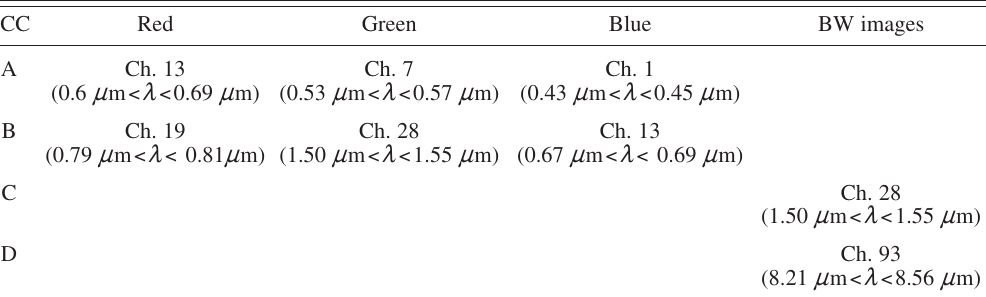
Table II. False Color Composites (FCC) and Black and White (BW) images used for photo-interpretation. A-com- binations of bands corresponding respectively, for vegetation, to the two bands with higher spectral absorption (red and blue colours) and the one with major reflectivity (green colour): it better approaches the natural colour repre- sentation; B-combinations of channels corresponding respectively to the maximum reflectance plateau in the Near- Infrared, the water absorption peak and chlorophyll peak; hence, this FCC highlights vegetation covers, discrimi- nating between agricultural lands and spontaneous vegetation; C- and D-BW images which allow to emphasize less easily detectable covers such as bare soils, vegetation sparse or in relative dryness